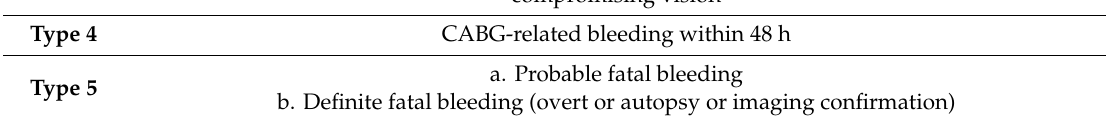
Table 1. Bleeding Academic Research Consortium definition for bleeding (modified from Mehran et al [24].). CABG, coronary artery bypass grafting; IV, intravenous.